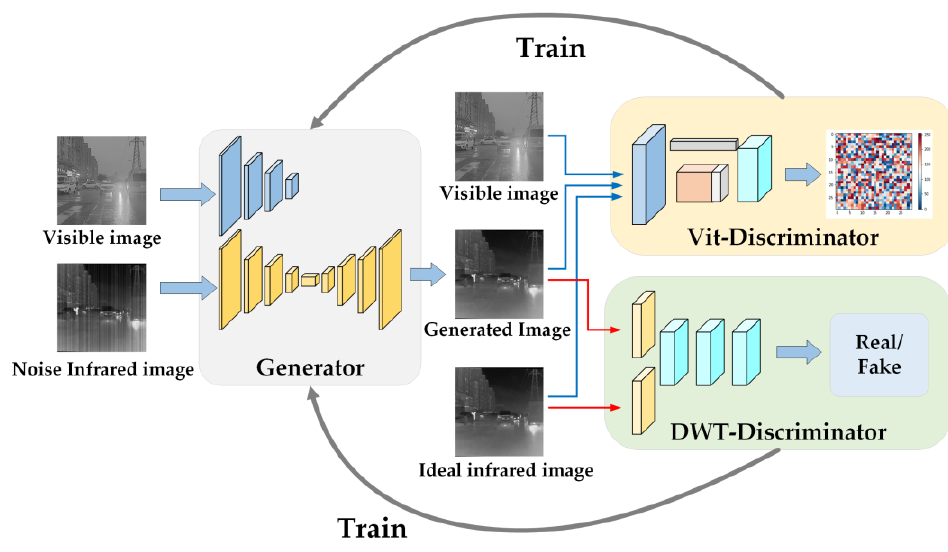
Figure 1. Algorithm flowchart.